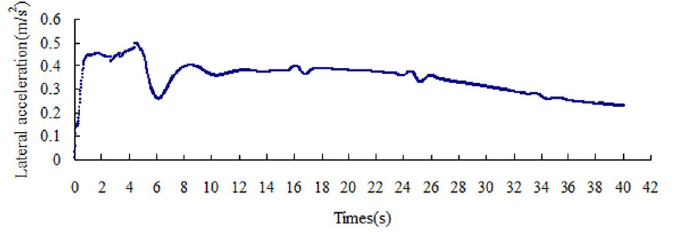
Fig 13. Lateral acceleration change graph of friction coefficient 0.6.